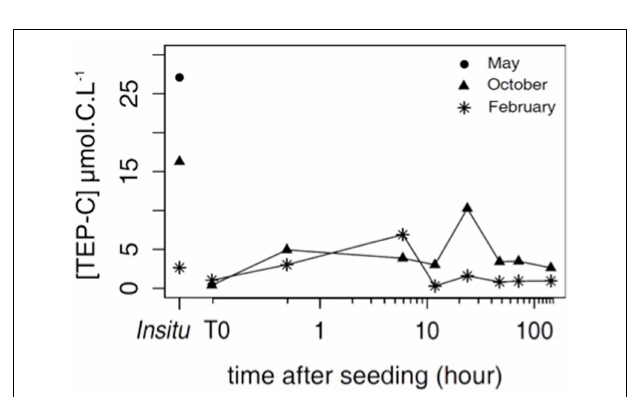
and PO 3 − 4 stocks ( = the difference in nutrient stock when the nutrient release was maximum compared to the initial stock); the light gray bar represents the change in NO − 3 and PO 3 − 4 stocks at the end of each experiment ( = the difference in nutrient stock between the final and the initial stock).